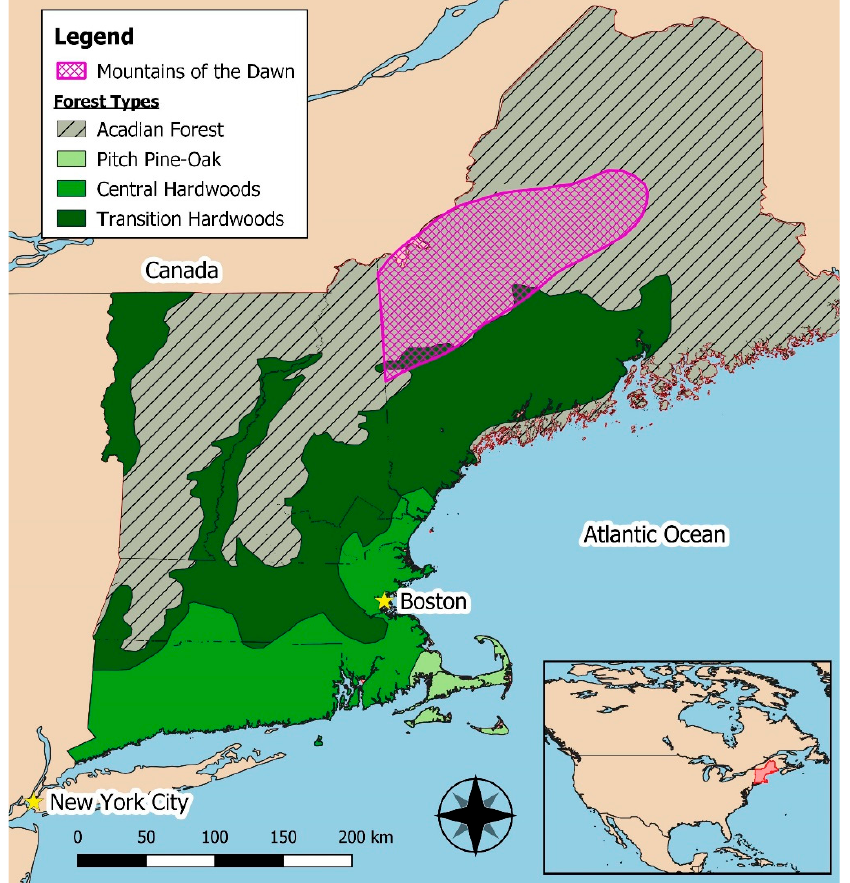
Figure 1. Forest regions of New England and mountains of the Dawn region. New England includes the states of Maine, New Hampshire, Vermont, Massachusetts, Rhode Island, and Connecticut. Forest regions adapted from Foster [20].